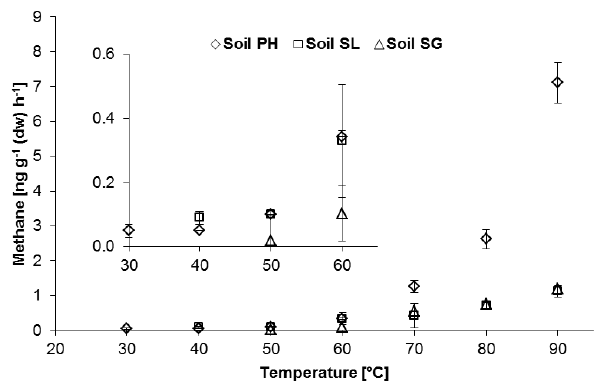
Fig. 1. Formation of CH 4 from soil with increasing temperature. Temperature dependence of CH 4 emissions from peat PH, soil SL and soil SG. Data show mean value ± SD ( n =5). Inset shows mag- nified area between 30 and 60 ◦